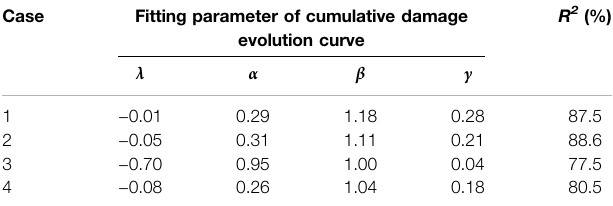
TABLE 3 | Parameters of cumulative